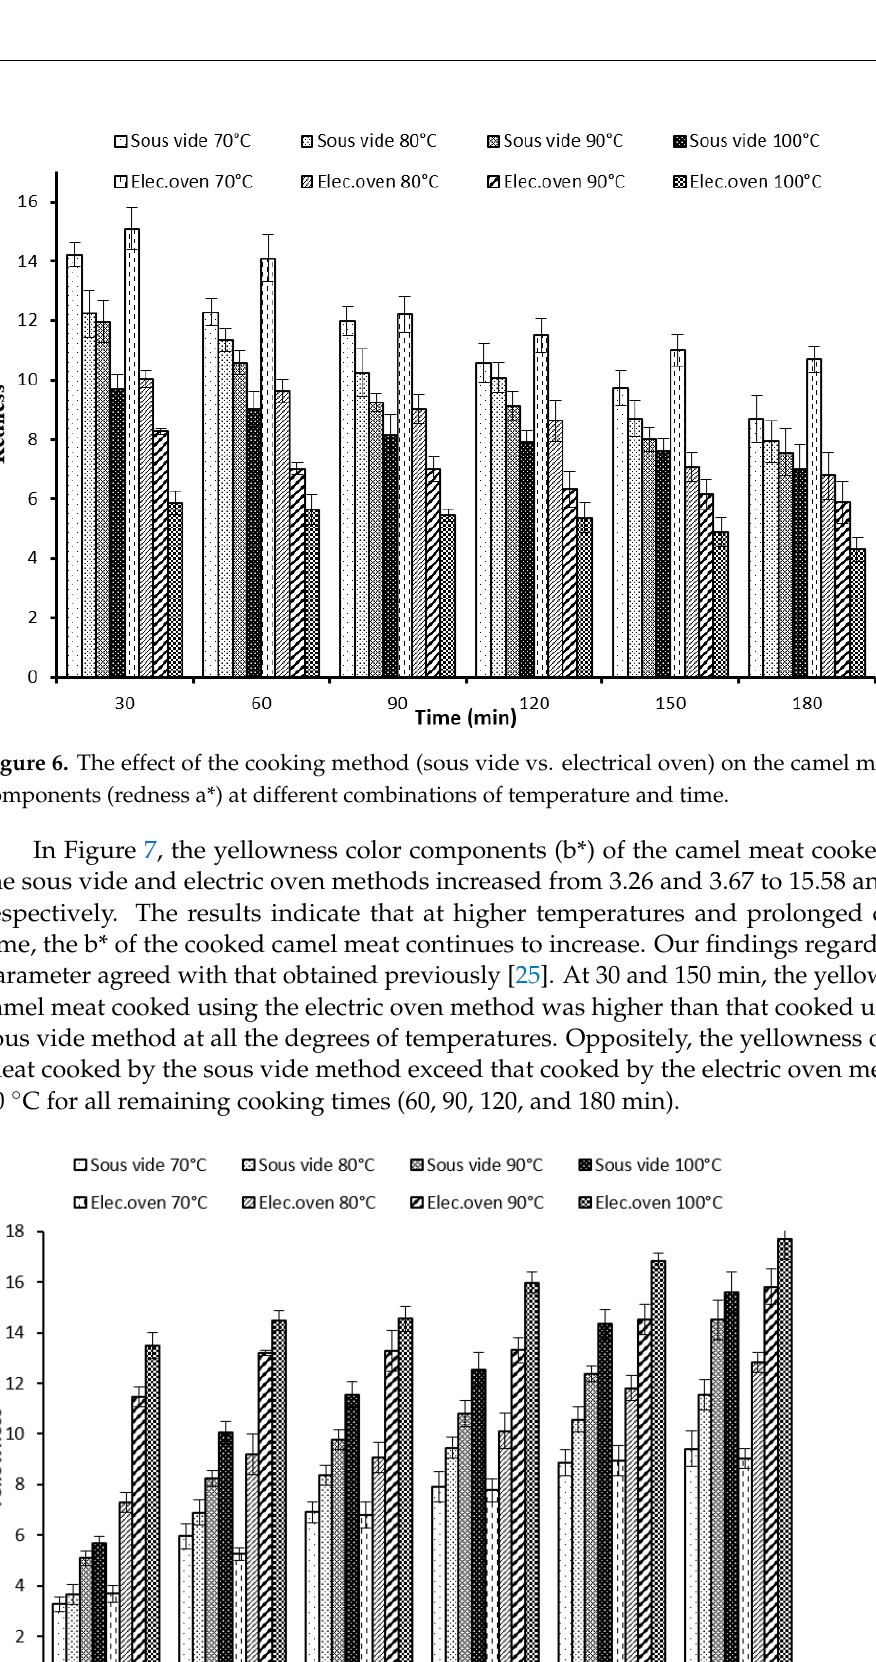
Figure 5. The effect of the cooking method (sous vide vs electrical oven) on the camel meat color components (lightness L*) at different combinations of temperature and time.